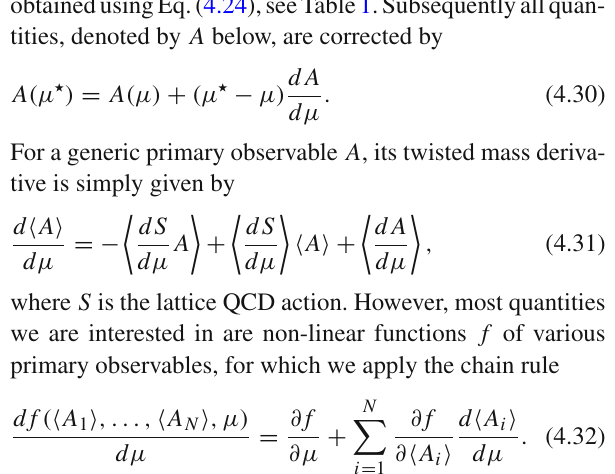
Fig. 2 The effective masses for heavy mesons made of a heavy quark h ( m h = 2 m c ) and a charm quark c on the W ensemble are displayed, together with the plateau average and its error band. We show the pseu- doscalar (violet circles) and vector (green squares)